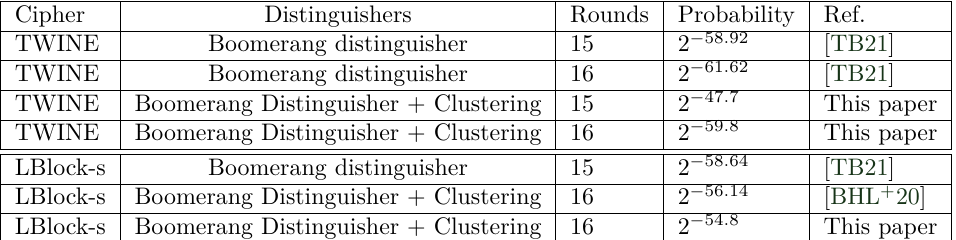
Table 5: Summary of the results for computing the best boomerang clusters for TWINE and LBlock-s.